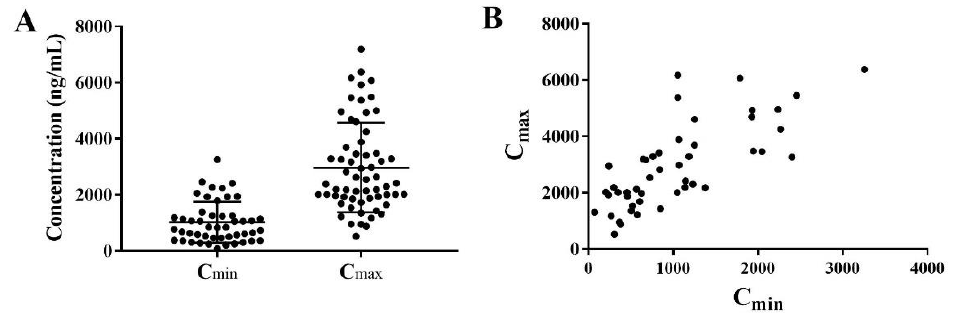
Figure 3. Distribution of venetoclax trough concentrations and peak concentrations in Chinese AML patients ( A )—summary of venetoclax concentrations, ( B )—paired of C min and C max ).